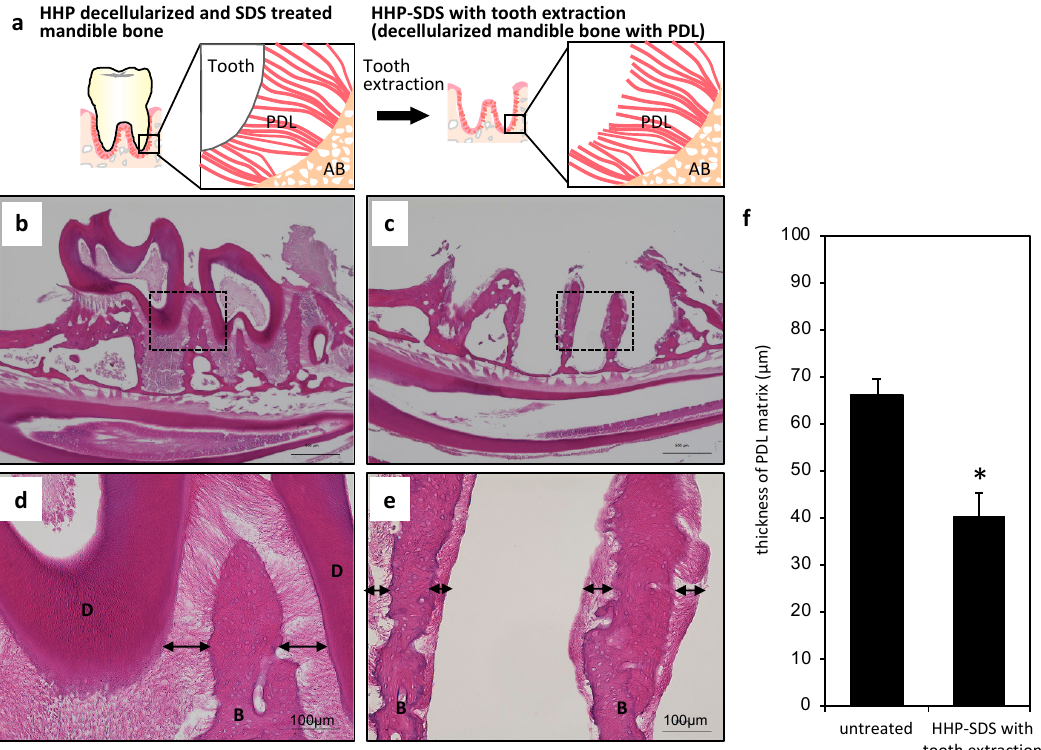
Figure 2. Sodium dodecyl sulfate (SDS) treatment and tooth extraction of decellularized mandible bone. ( a ) Schematic illustration of the tooth extraction process. ( b – e ) HE-stained images of HHP-decellularized ( b , d ) and SDS-treated ( c , e ) mandible bone with tooth extraction. Arrows indicate the PDL matrix area. B, alveolar bone; D, dentin. ( f ) Measurement of PDL matrix thickness ( n = 5). * p < 0.05.